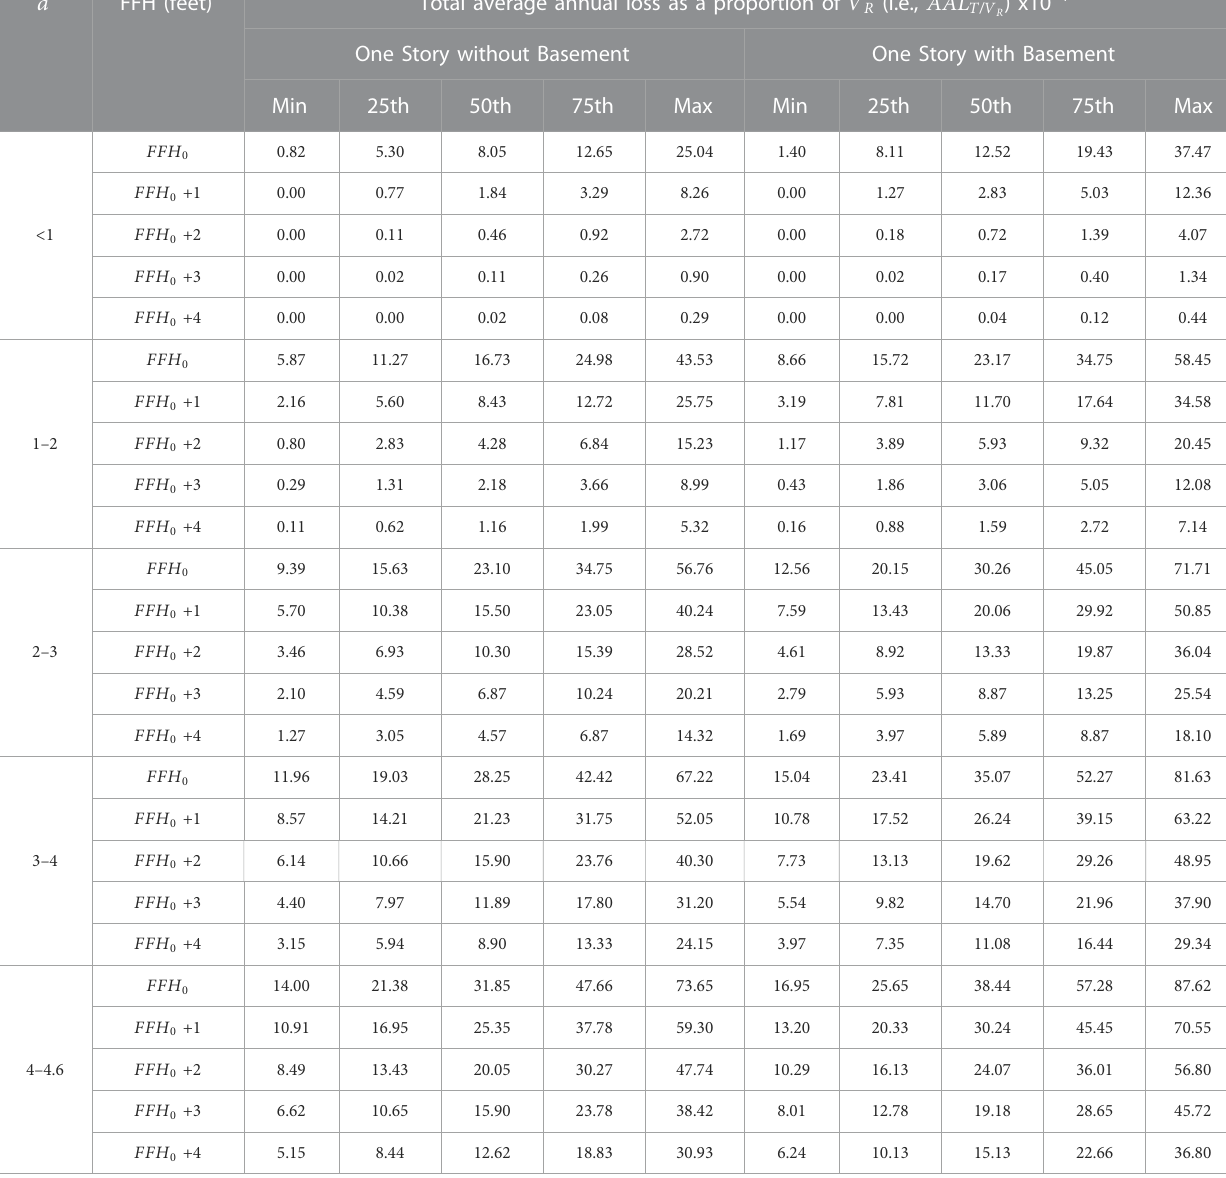
TABLE 5 As in Table 3 but categorized based on the a parameter. a FFH